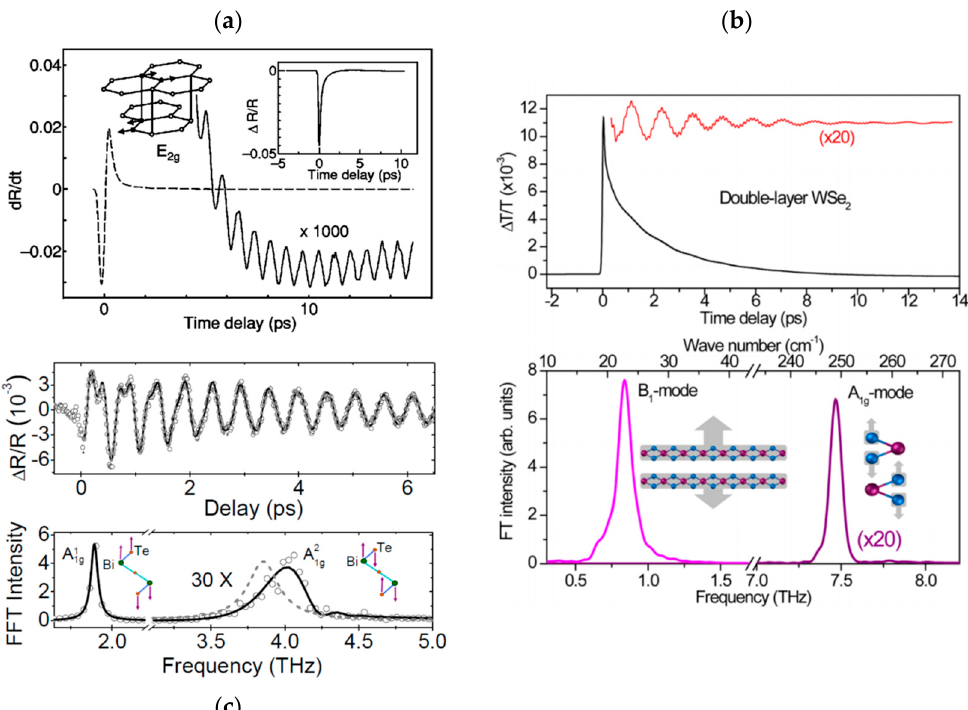
Figure 5. ( a ) Time-domain optical signal, here transient reflectance, measured in bulk graphite, with extraction of oscillations related to coherent optical phonons (COPs). Reprinted with permission from [229], Copyright © 2000 by the American Physical Society. ( b ) Time-domain optical signal, here (top) transient transmittance and (bottom) corresponding spectrum, measured in bilayer WSe 2 , with extraction of both coherent optical and resonant phonons. Reprinted with permission from [133], Copyright © 2016, American Chemical Society. ( c ) Time-domain optical signal, here (top) transient reflectance and (bottom) corresponding spectrum, measured in Bi 2 Te 3 . Reprinted with permission from [233], Copyright © EPLA, 2010. Schematics of the respective modes are presented in insets.